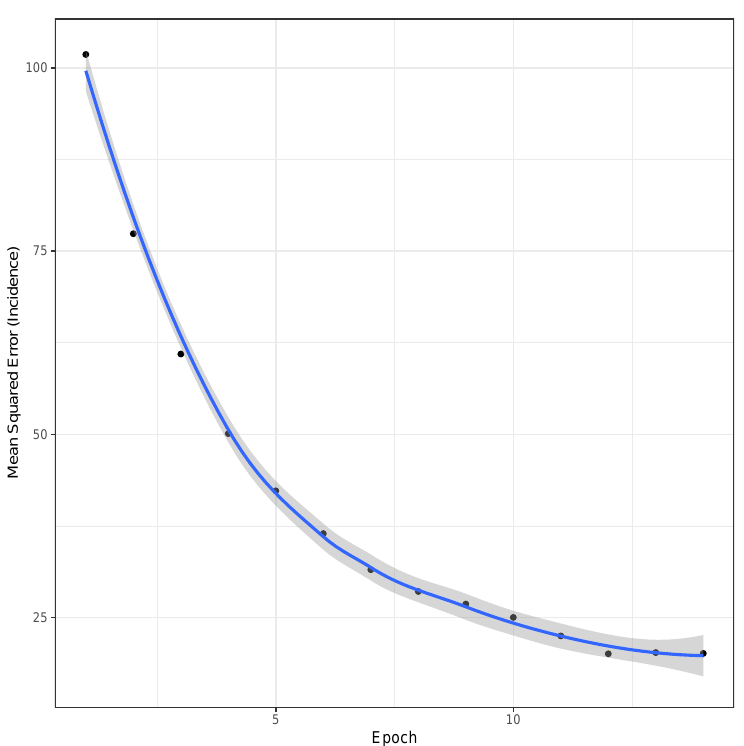
Figure A1. The mean squared error for counts is reported in the vertical axis at each optimization step (horizontal axis) for train sequences.